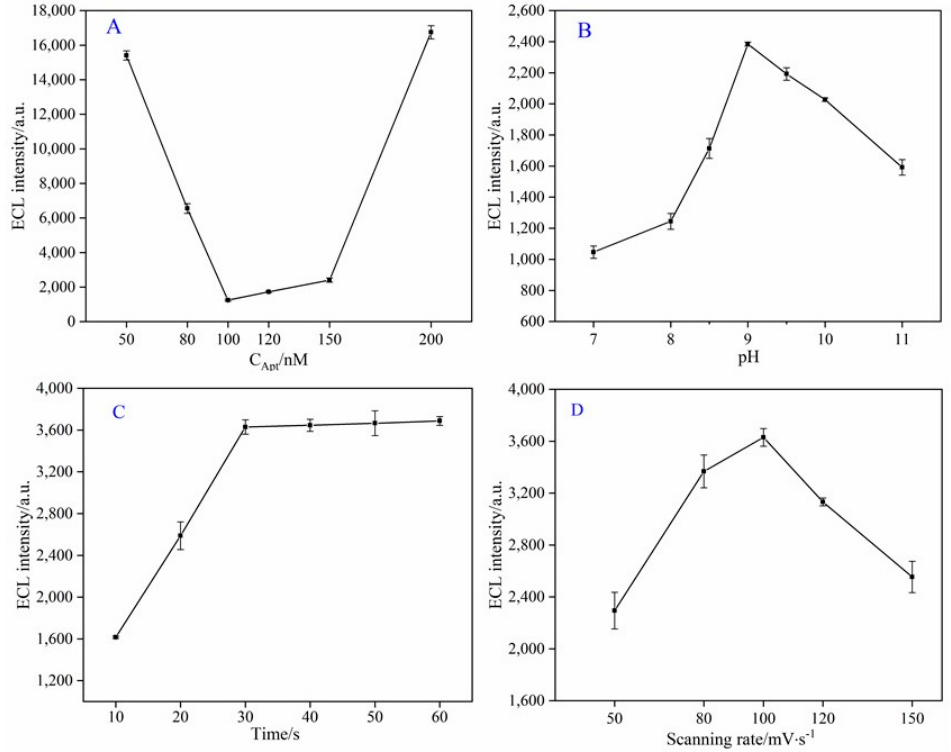
Figure 3. Optimization of four experimental parameters: ( A ) the aptamer concentration; ( B ) pH of PBS; ( C ) the incubation time; ( D ) the scanning rate.